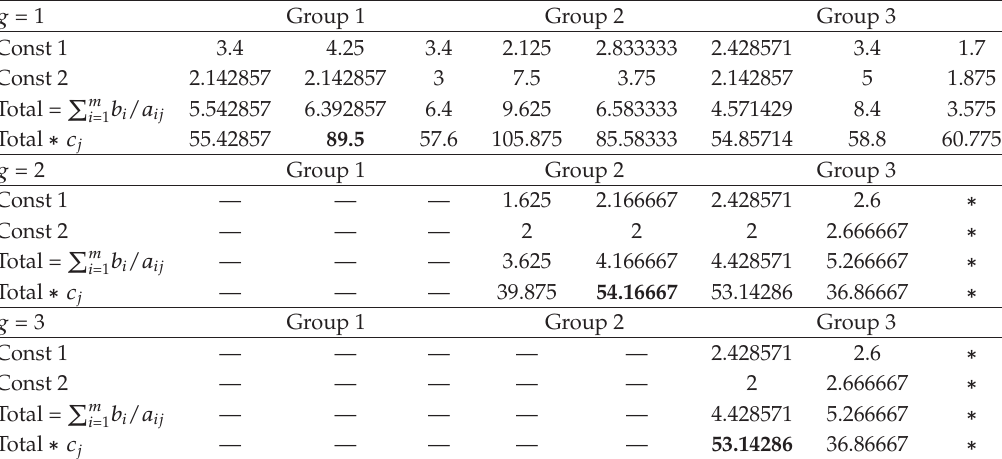
Table 1: First Iteration reports of